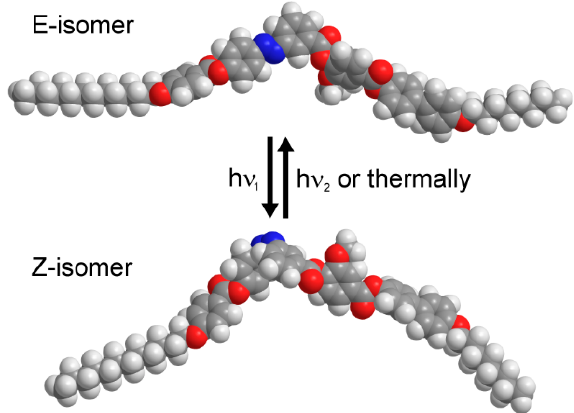
Figure 8. Changes of the molecular shape upon E-Z isomerization.